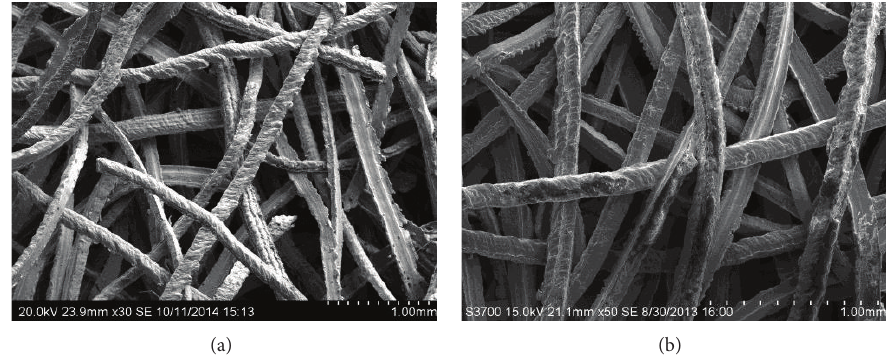
Figure 2: SEM images of (a) SSSFF before sintering and (b) SSSFF sintered at 1100 ∘ C for 60 min.